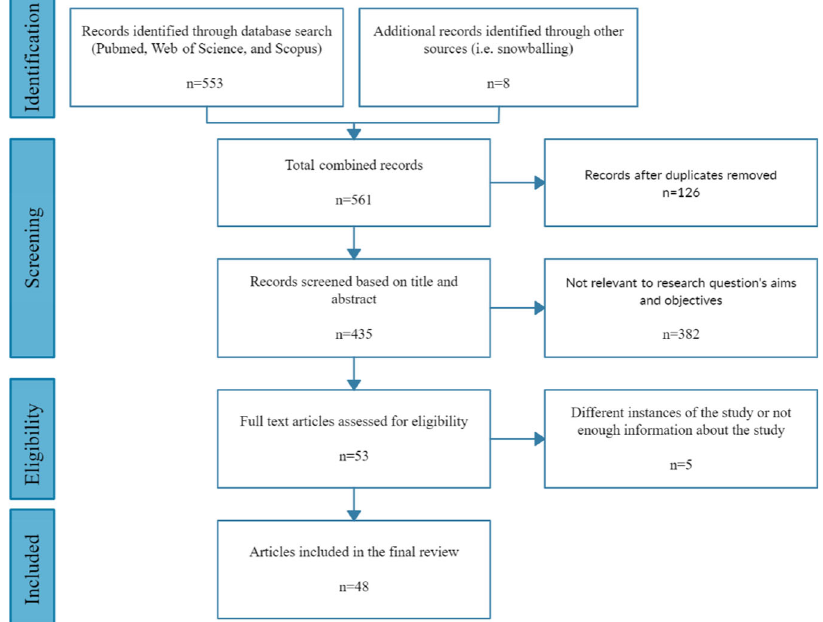
Fig. 1 PRISMA fl owchart. The diagram shows the study selection process conducted for the purpose of reviewing the use of sensors and machine/deep learning techniques for objectively assessing human